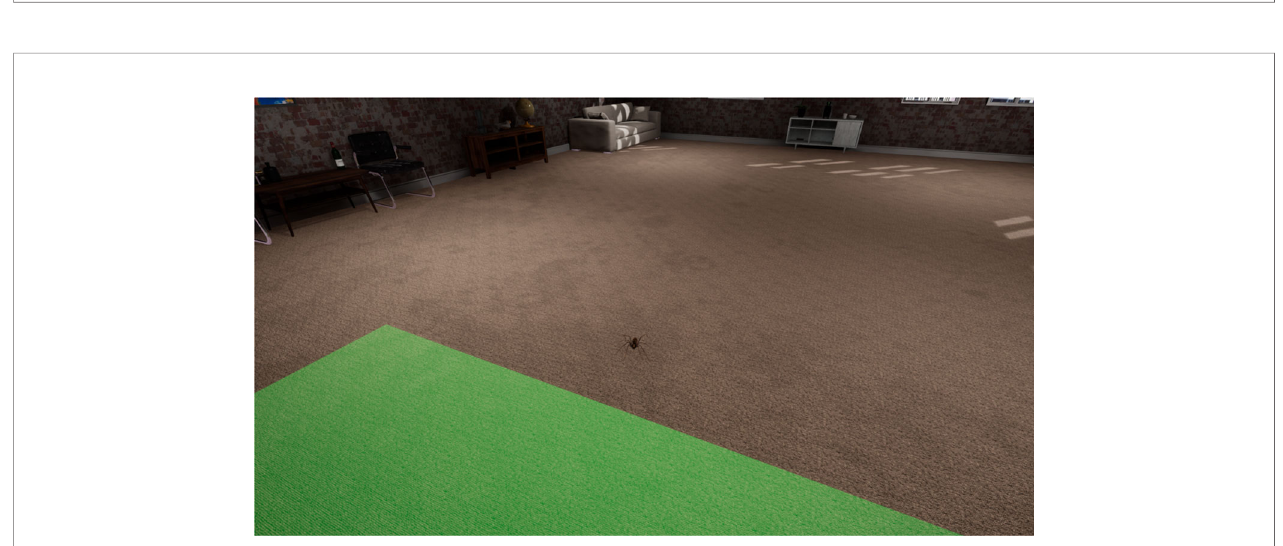
FIGURE 6 | A static screenshot from the virtual reality environment within which each participant can control their distance from a naturalistically moving spider. Original show whether incorporating reorganization into the model can demonstrate the patterns of change that are shown within spider- fearful individuals who are exposed to the spider within VR; namely, the sudden reduction of distance from the spider after